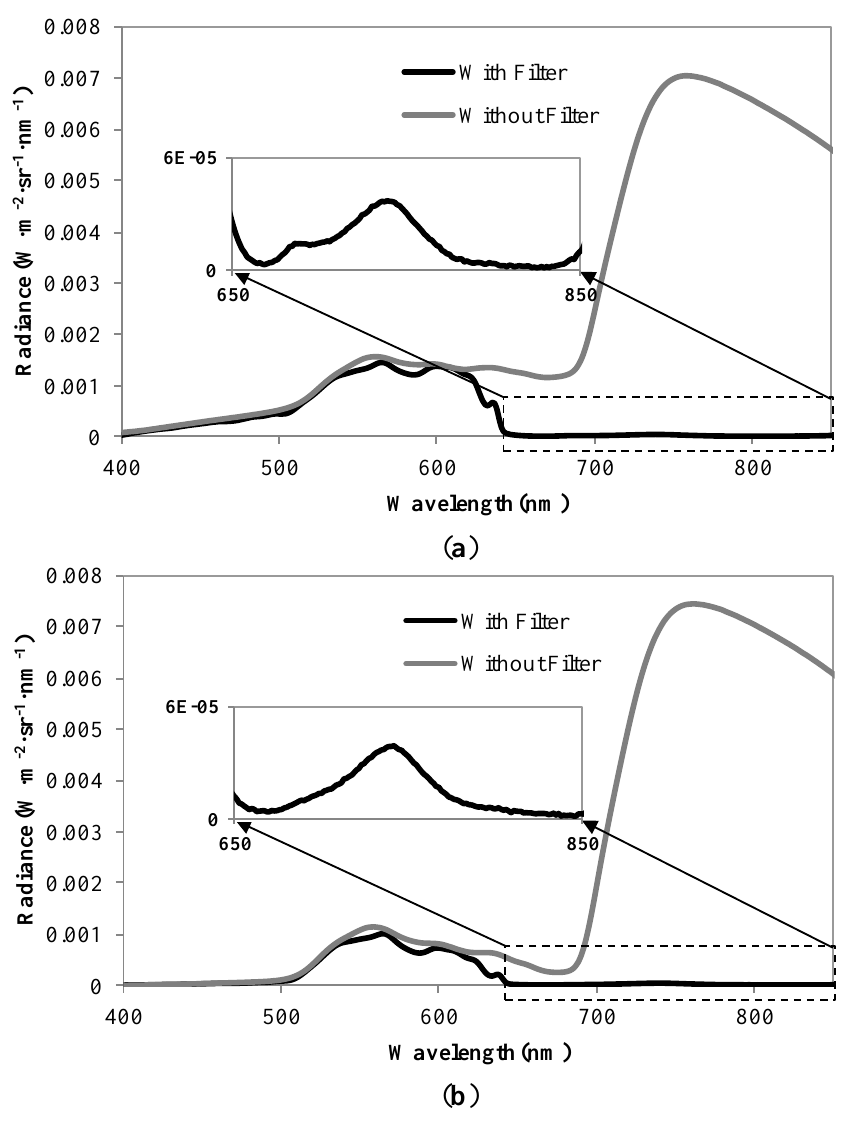
Figure 4. Examples of the radiance spectra of the leaf sample with and without the filter when measuring ( a ) backward fluorescence and ( b ) forward fluorescence. Insets: distributions of measured leaf backward and forward fluorescence radiance with the same unit but in finer